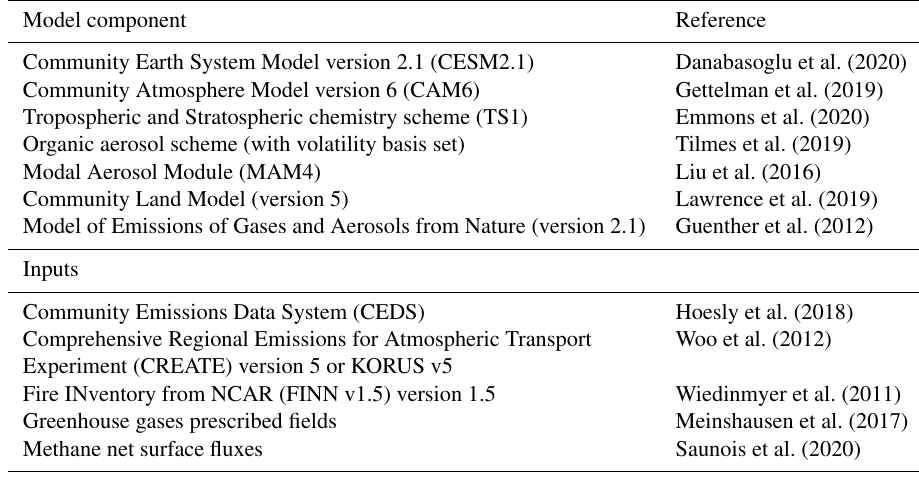
Table 1. Summary of the main model components and references for CESM2.1 and